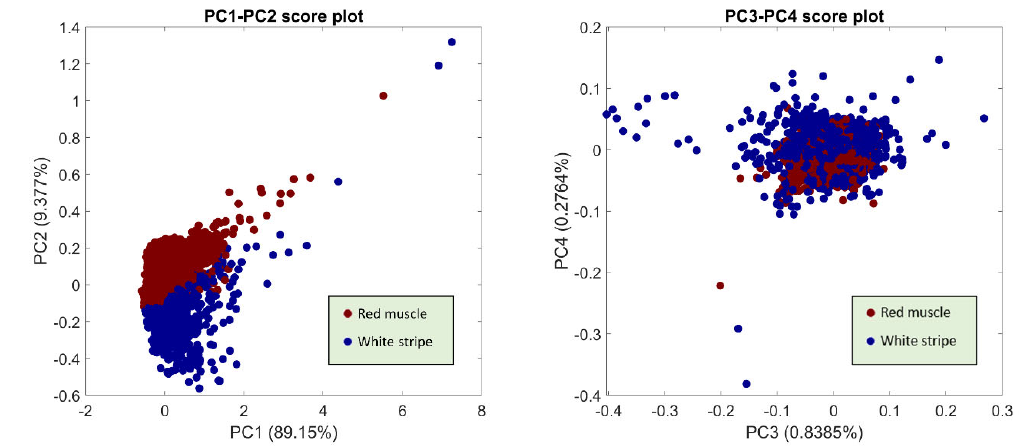
Figure 10. PCA scatter plots from the first four PCs. Explained variance of each PC is indicated in